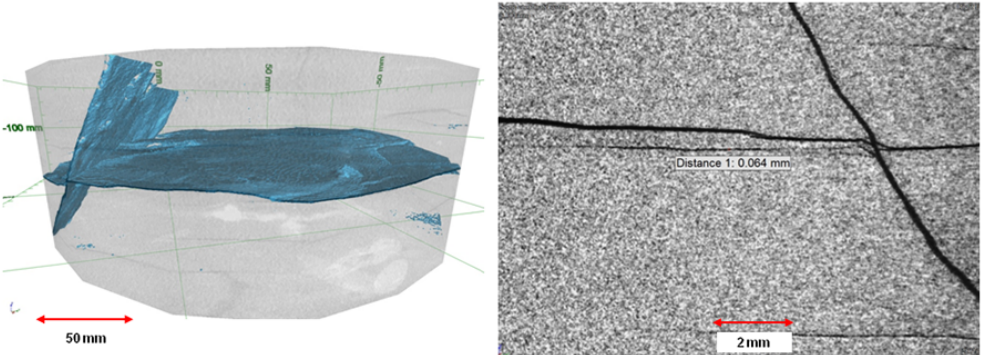
Figure 7. The main fractures have been segmented (left-hand side) and visualized in a transparent 3-D view. Besides the two major cracks, numerous tiny cracks can be detected. The fracture width can be measured down to approximately 60µm.